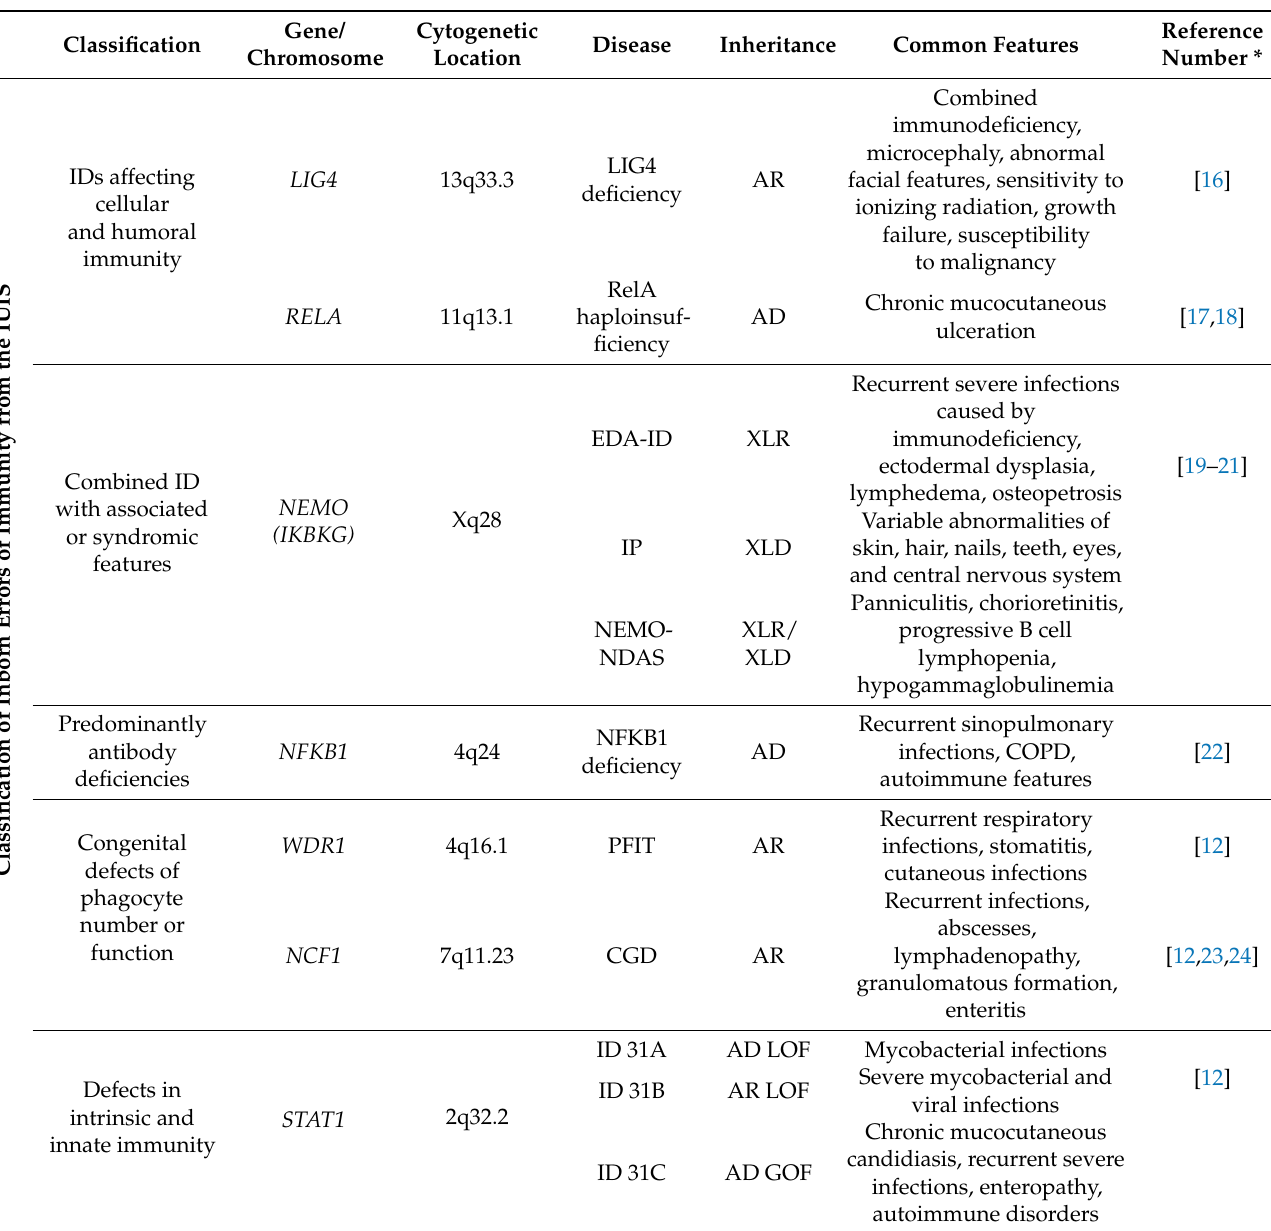
Table 1. Summary of PID-related genes and the chromosomes associated with BD-like phenotypes.